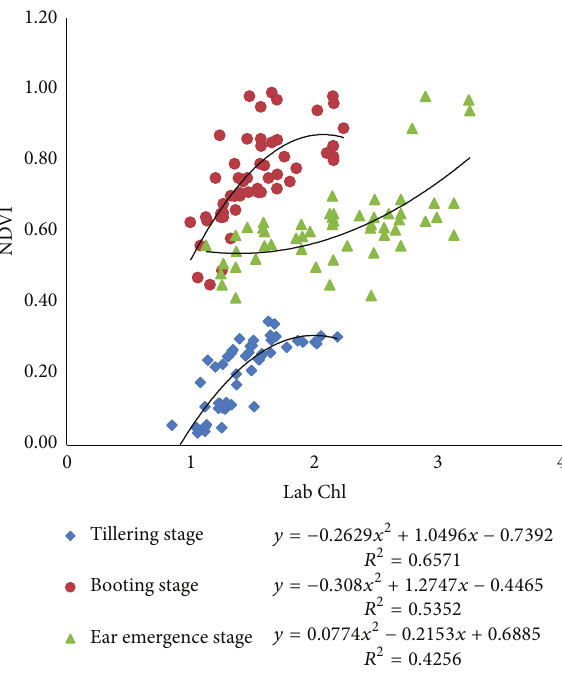
Figure 15: Correlations between NDVI calculated from N-sensor data and Lab Chl at different crop growth